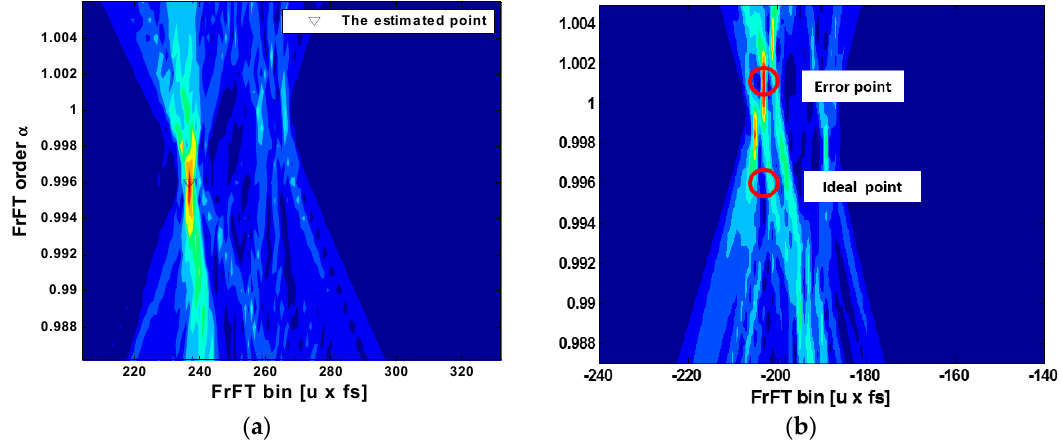
Figure 17. Color intensity of the FrFT results in ( a ) the correctly estimated symbol and ( b ) the incorrectly estimated symbol.